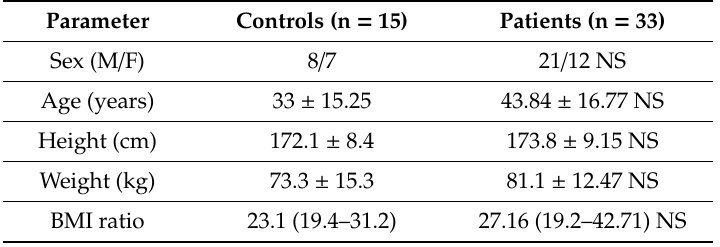
Table 1. Basal characteristic of control group and patient